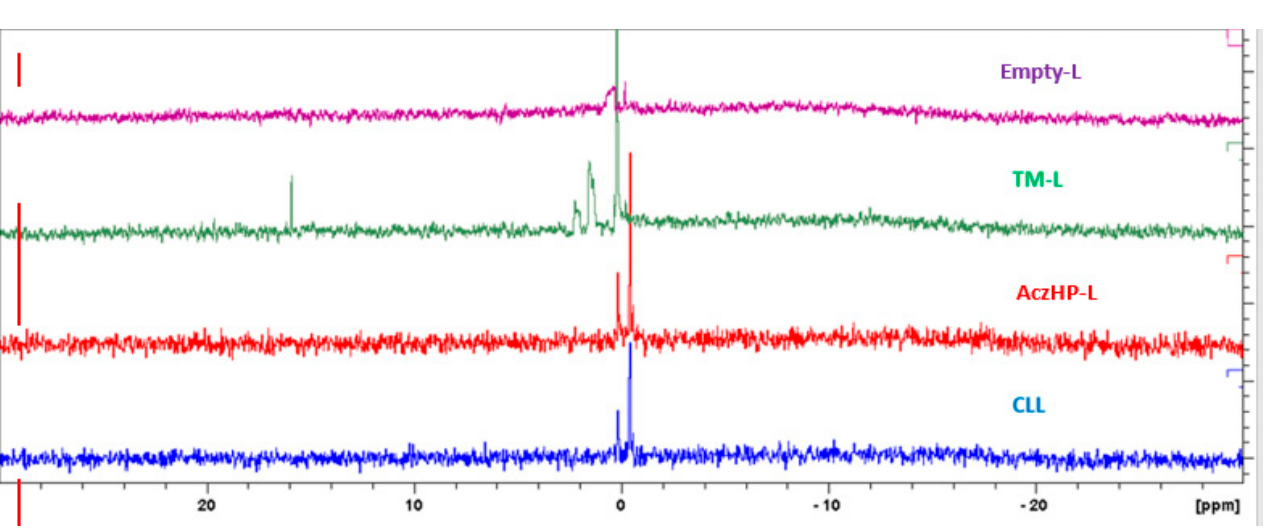
Figure 6. 31 PNMR spectra corresponding to empty liposomes (Empty-L), timolol-loaded liposomes (TM-L), acetazolamide–HP β CD- loaded liposomes (AczHP-L), and TM–AczHP co-loaded liposomes (CLLs).